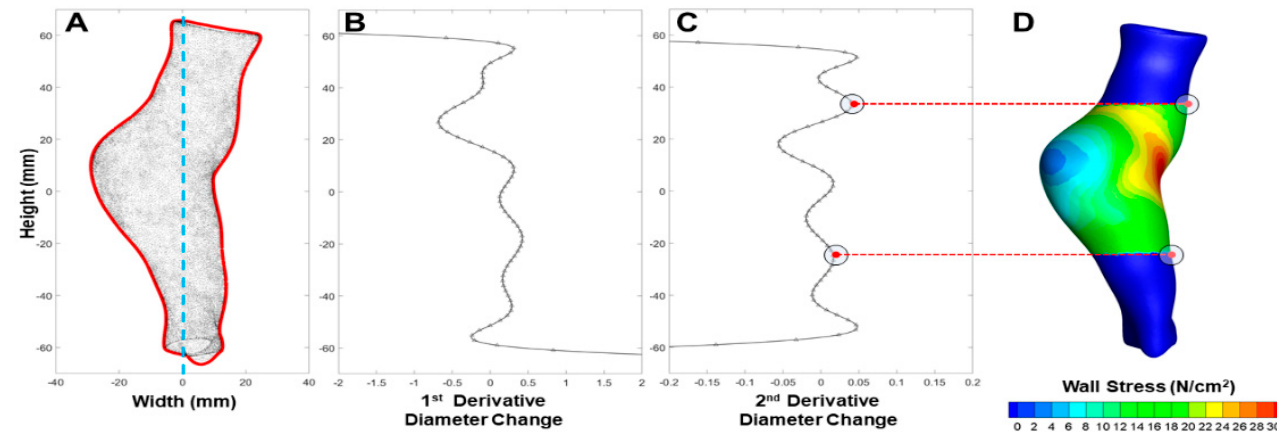
Figure 2. ( A ) 3D Scatter plot of an AAA model with the projected 2D boundary in red and a dividing blue line to split the left and right curves. A Fourier series (2) fit for the right projected boundary curve. ( B ) Subsequent first derivative of functionalized Fourier series. ( C ) The 2nd derivative of the Fourier series with the local extrema identified. ( D ) Sac isolated model in the same 2D projected view with local extrema assigning the superior and inferior boundaries on the right side of the an-eurysm.